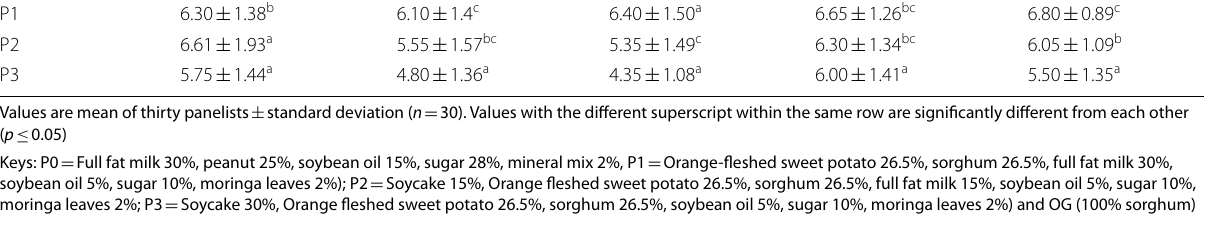
Table 8 Sensory attributes of therapeutic complementary foods